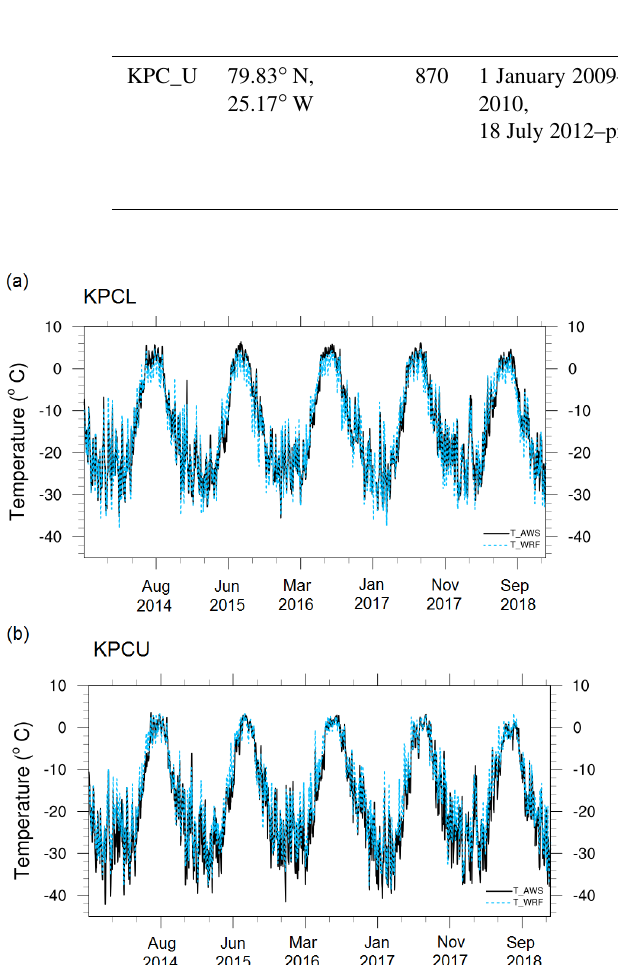
Figure 3. The observed (black lines) and modelled (dashed blue lines) daily average air temperature at KPC_L (a) and KPC_U (b) from D03.